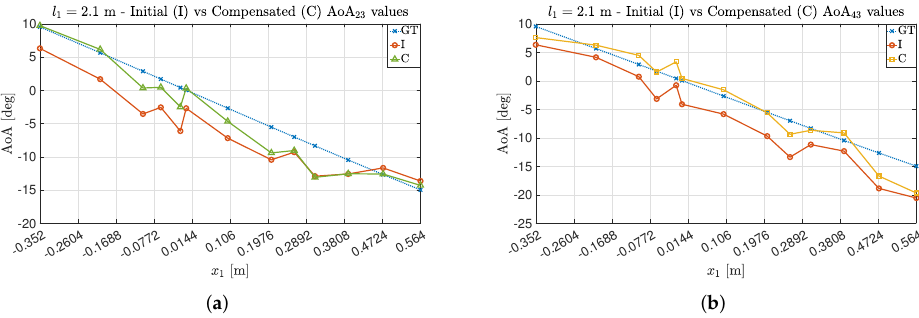
Figure 8. AoA estimation values for Exp#1 before and after compensation obtained for ( a ) the antenna couple { 23 } and ( b ) the antenna couple { 43 } .